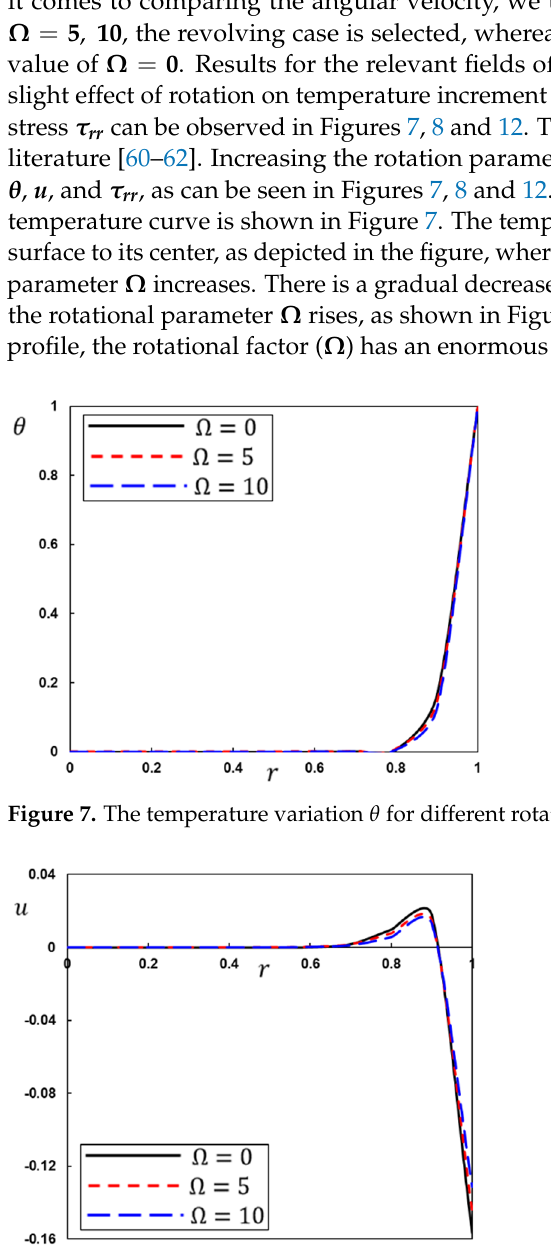
Figure 9. The carrier density 𝑁 for different rotation parameter Ω .